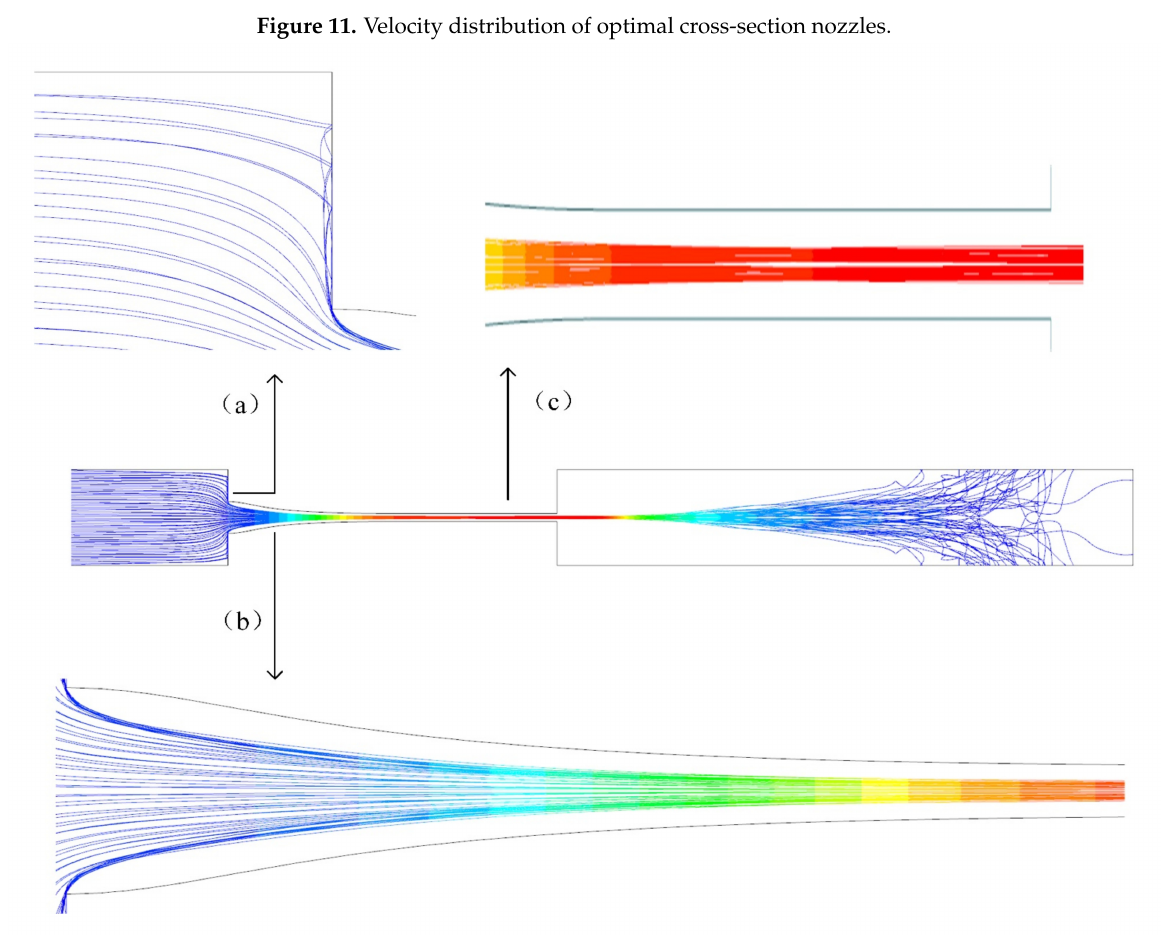
Figure 12. Abrasive particle trajectory of nozzle with optimal configuration. ( a ) Trajectory of abrasive particles at nozzle end surface; ( b ) Trajectory of abrasive particles in contraction section; ( c ) Trajectory of abrasive particles in focusing